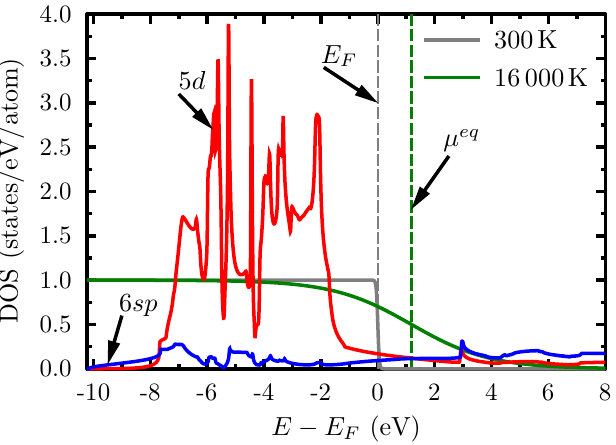
Figure 4. Partial density of states for the 5 d - and 6 sp -bands of gold. The equilibrium Fermi distributions for 300 K and 16,000 K are shown and the shift in chemical potential after heating is indicated. The energy scale is given relative to the Fermi